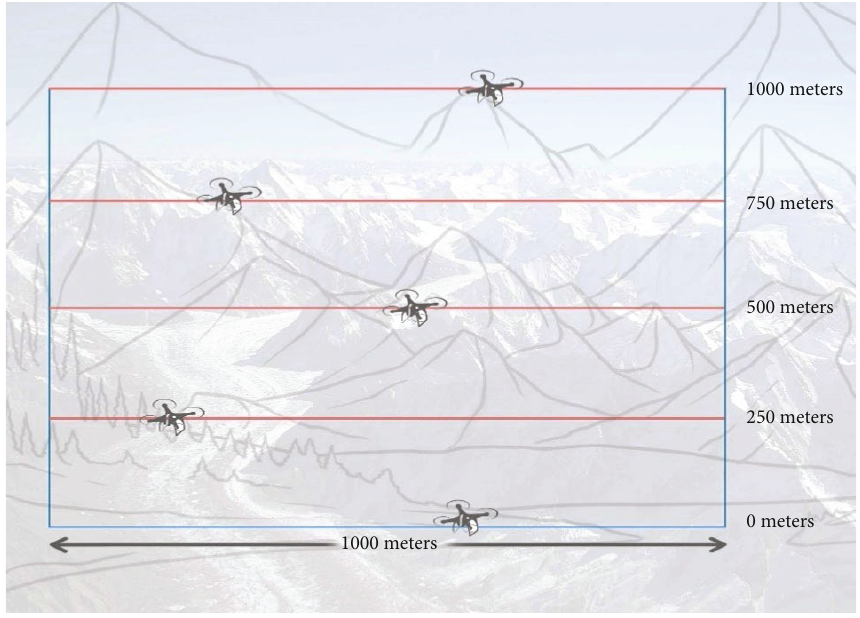
Figure 18: Operational mission pro fi le. Table 3: Operational mission pro fi